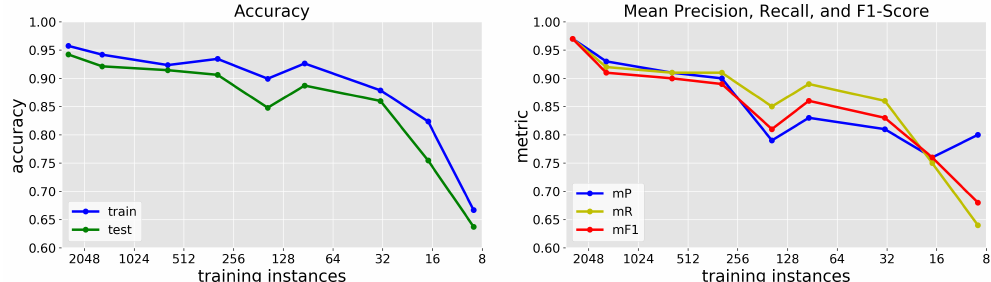
Figure 13. Overall training and testing accuracy ( left ) and weighted mean precision, recall, and F 1 score (B) of CNN Model 2 trained on a variable number of hand-labeled examples from Scene 1-a and tested on the testing set of the same scene. As the training set decreases in size, the overall accuracy, mean precision, and mean recall decrease by as much as ∼ 40%.